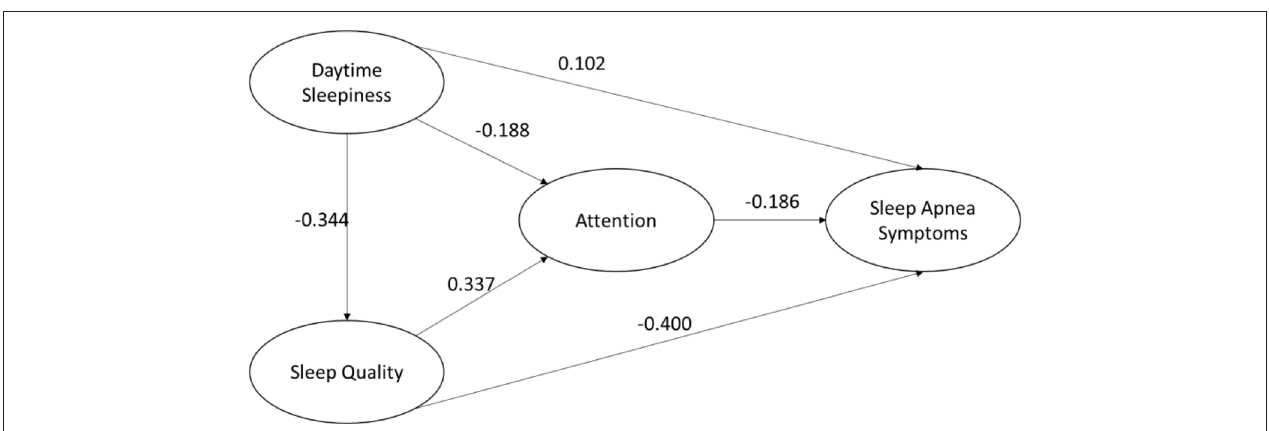
FIGURE 2 | Statistical model